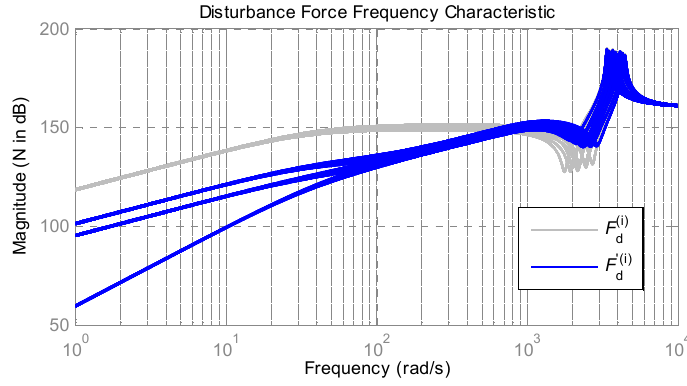
Figure 6. Disturbance force after constant